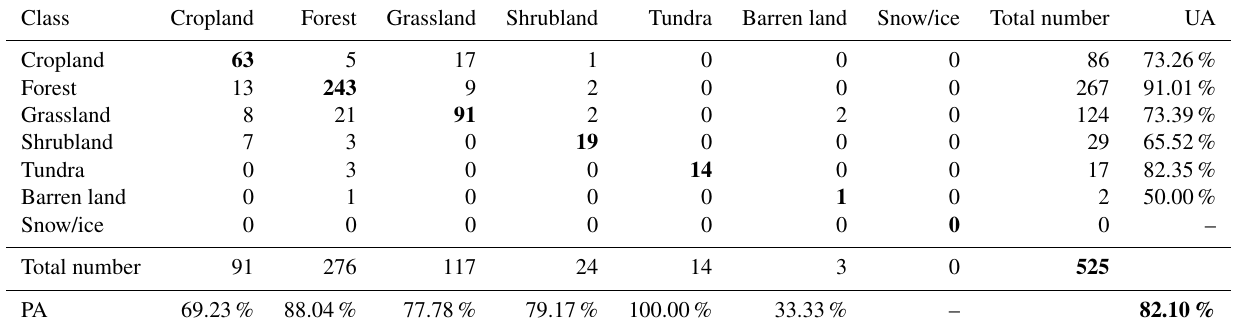
Table 4. Classification accuracy of GLASS-GLC (annual dynamics of global land cover) in 2015 based on FLUXNET test samples (overall accuracy = 82.10%; UA denotes user’s accuracy, and PA denotes producer’s accuracy). Bold numbers represent correctly classified